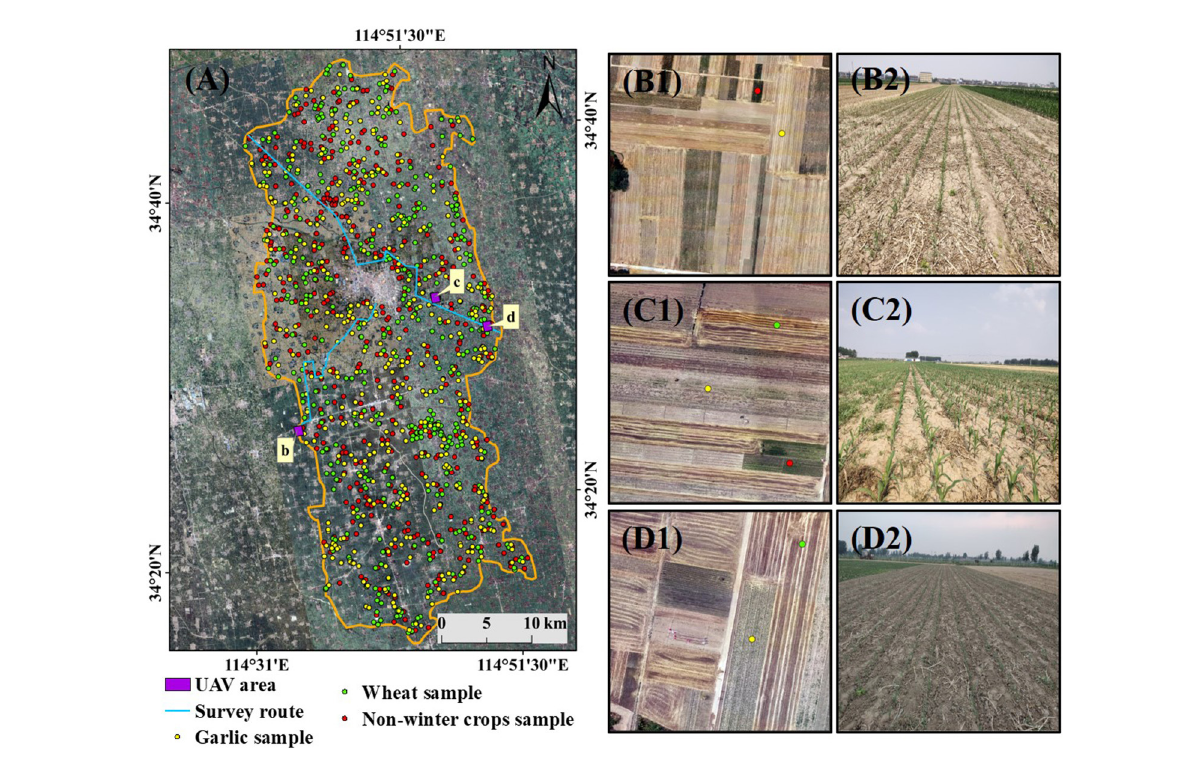
FIGURE4 (A) Distribution of validation samples, including garlic, wheat, and non-winter crops. (B1–D1) Are the UAV images. (B2–D2) Are the ground observations from the field camera photograph. (B1,B2) , (C1,C2) , and (D1,D2) correspond to b, c, d in (A) ,